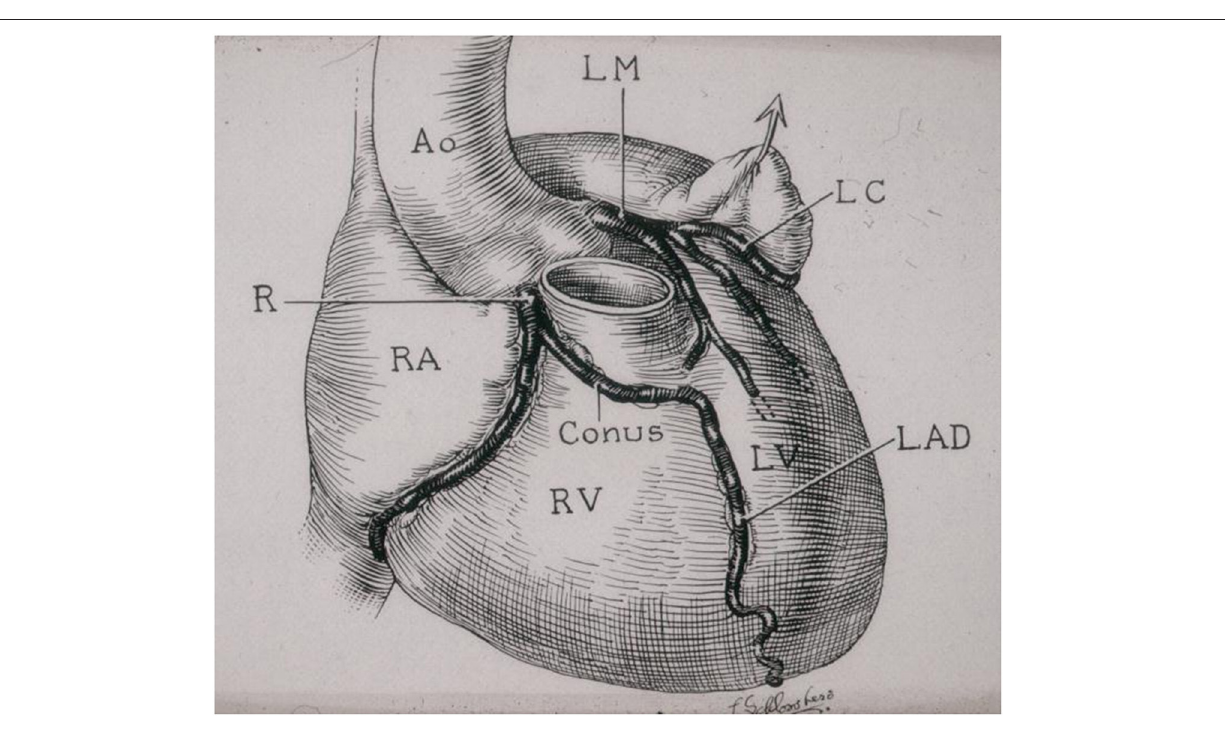
Frontiers in Cardiovascular Medicine |